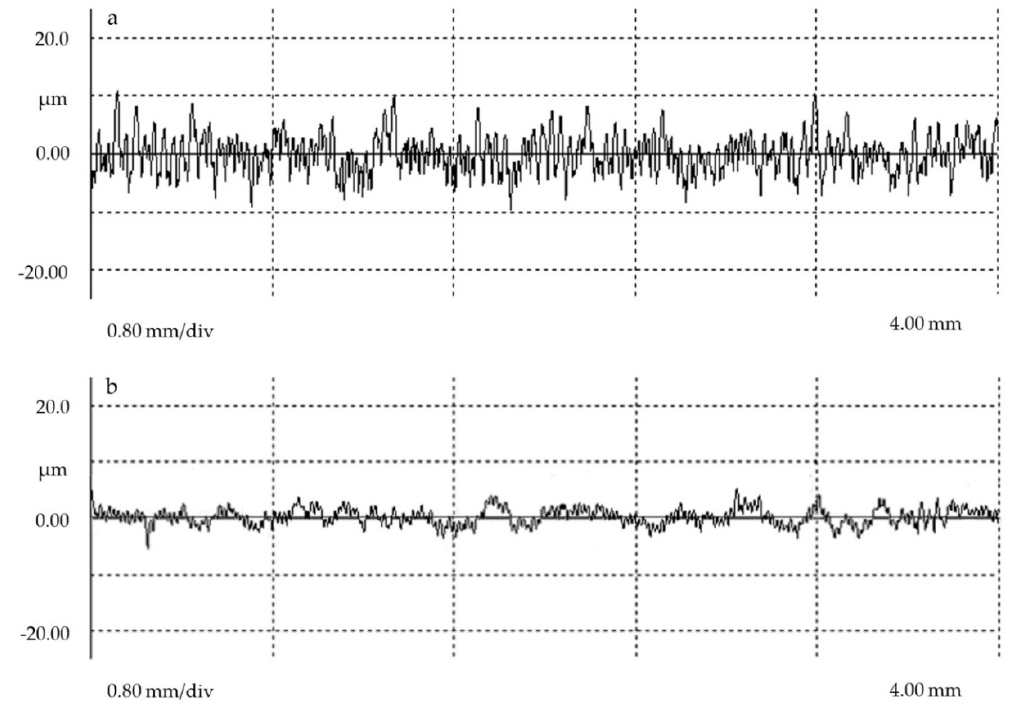
Figure 10. Surface free energy values for water jet texturing tests.